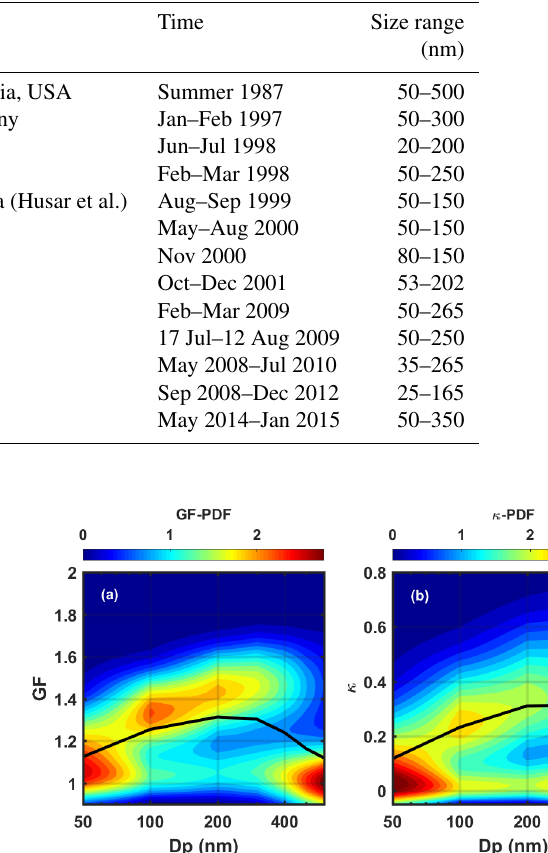
Table 1. Summary of previous HTDMA measurement of urban aerosol particles.